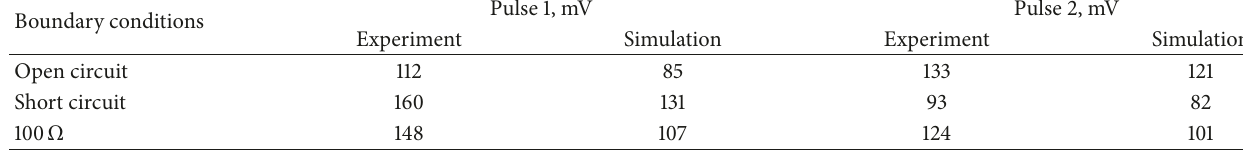
Table 8: Pulse amplitudes for different boundary conditions at the ends of the probed wire for experiment and simulation.